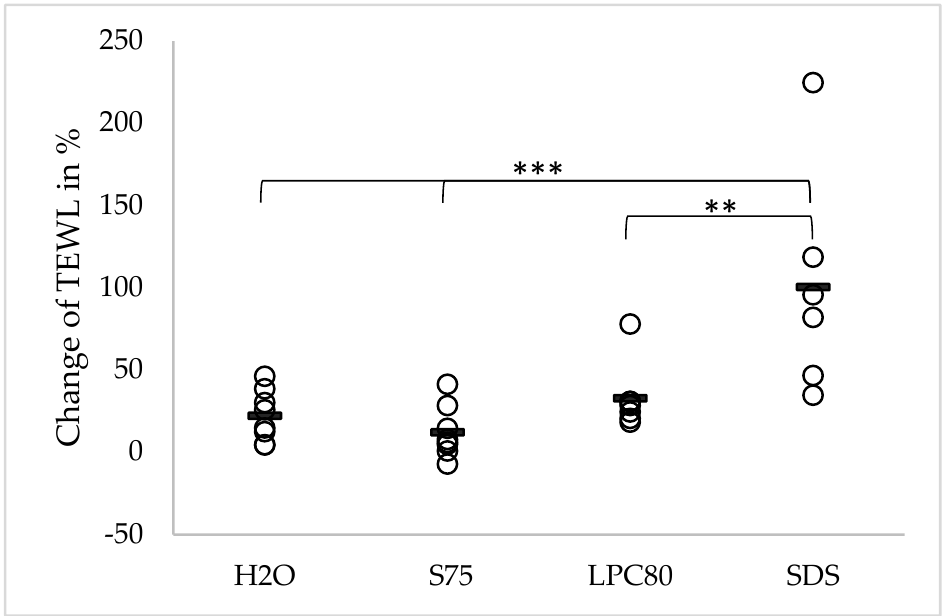
Figure 1. Effect of water and the three different surfactants lecithin S75, lecithin LPC80 and SDS on transepidermal water loss (TEWL) after four days of repeated exposure. Parameter changes were calculated using Equation (1) and are expressed as single values ( n = 8, SDS values n = 6) and the corresponding mean. Statistically significant differences are marked with asterisks (** p < 0.01, *** p < 0.001) and were tested with a one-way ANOVA + post-hoc Tukey test with p < 0.05 as minimum level of significance.